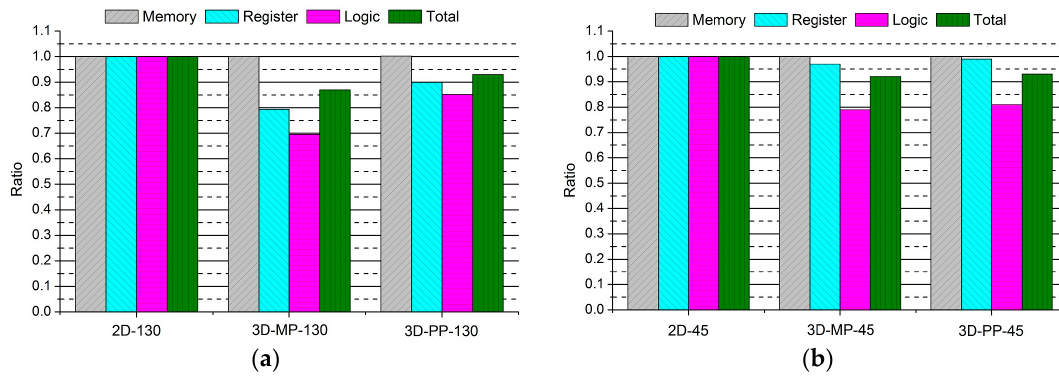
Figure 13. Normalized power comparisons of 2D and 3D ICs: ( a ) 130-nm process technology and ( b ) 45-nm process technology. Sensors 2017 , 17 , 426